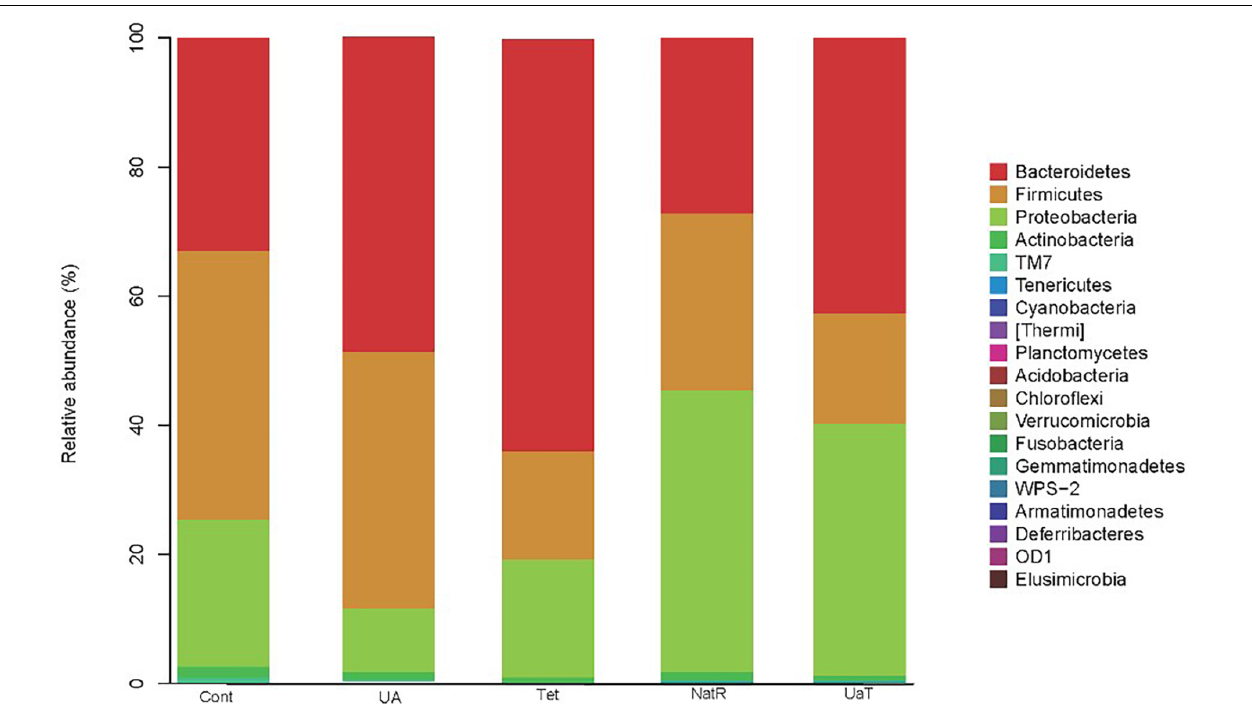
FIGURE 8 | The relative abundances of the colonic microbiota at the phylum levels. The relative abundances of the gut bacteria presented here were calculated by averaging the data obtained from the five replicates within each group. All group names correspond to those described in the legend of Figure 2 .